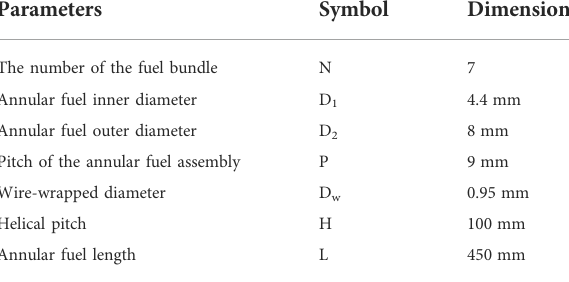
TABLE 1 Geometric parameters.